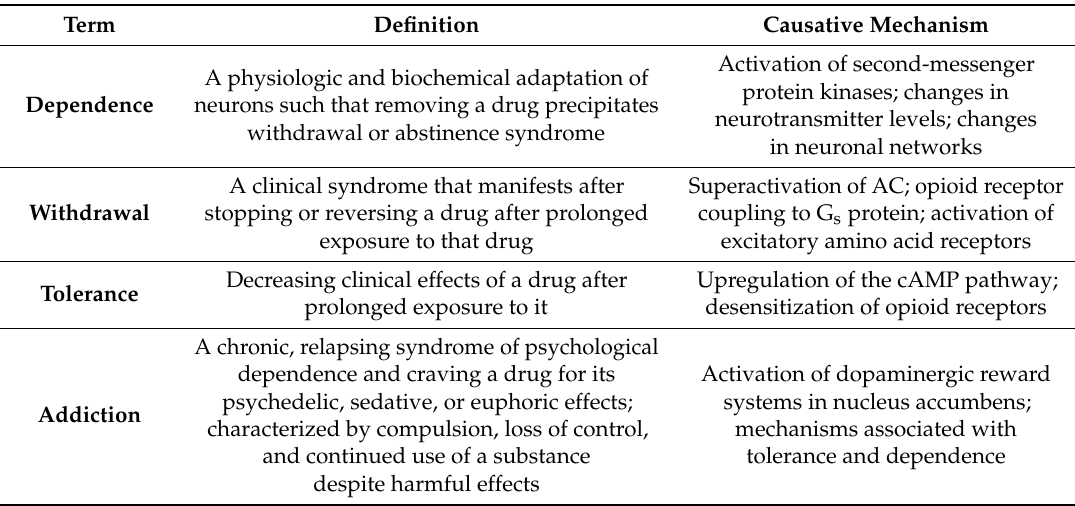
Table 1. Summary of physiological effects